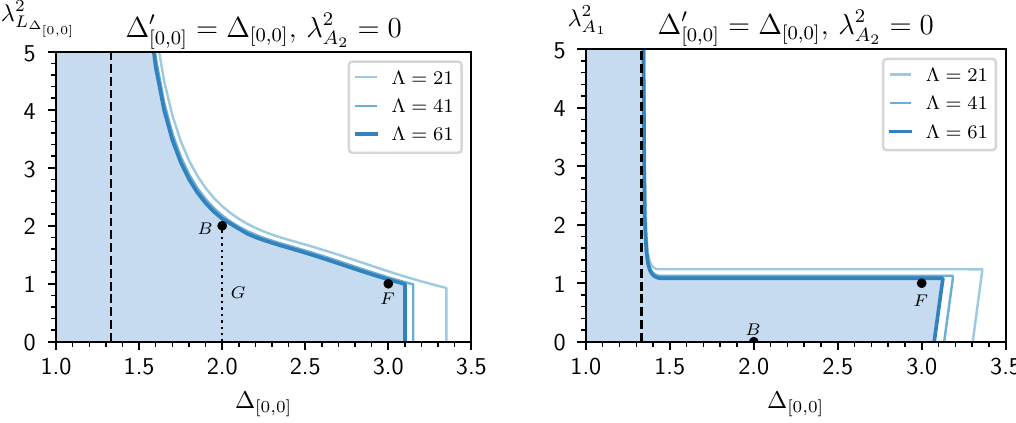
Figure 3 . Left: upper bound on the OPE coe(cid:14)cient of the isolated long as a function of its dimension (cid:1) . Right: upper bound on the OPE coe(cid:14)cient of the [ A 1 ] j =1 = 2 [0 ; 0] function of the dimension of the (cid:12)rst long (cid:1) & 2. The upper bound of both OPE coe(cid:14)cients diverges for (cid:1) (cid:1) = (cid:1) 0 [1 ; 0] [1 ; 0] represented with a vertical dashed